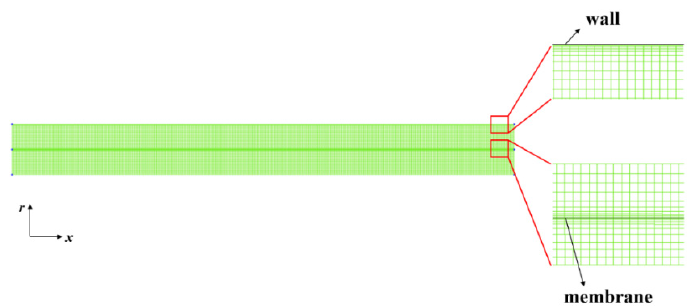
Figure 2. Profile of mesh distribution and refinement.